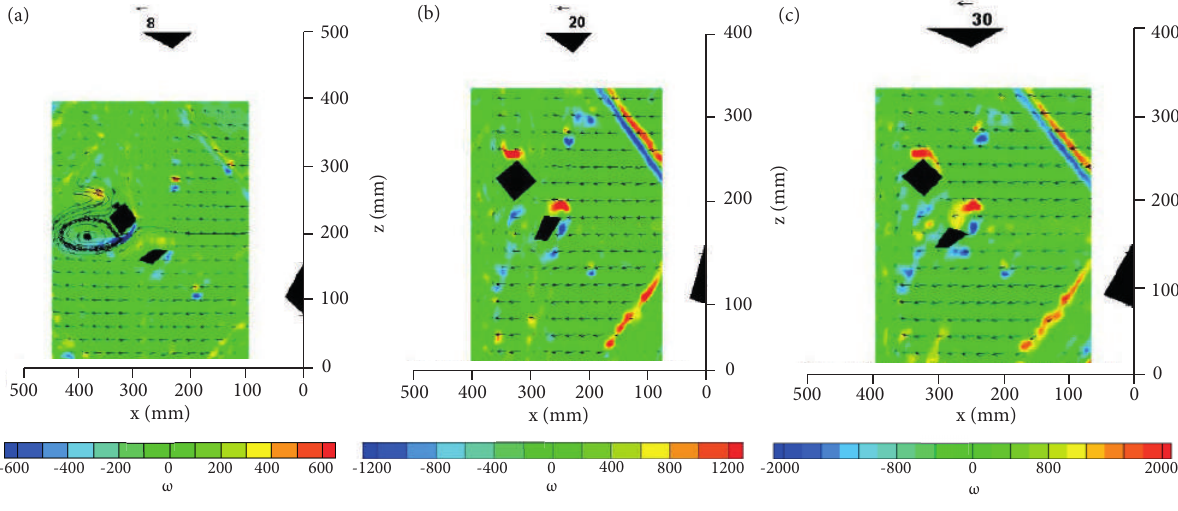
Figure 24. Vorticity contours and velocity vectors varying the coastal cliff inclination and the Re number with y/L = 0.96, α = 45°. (a) β = 45º; (b) β = 90°; (c) β =